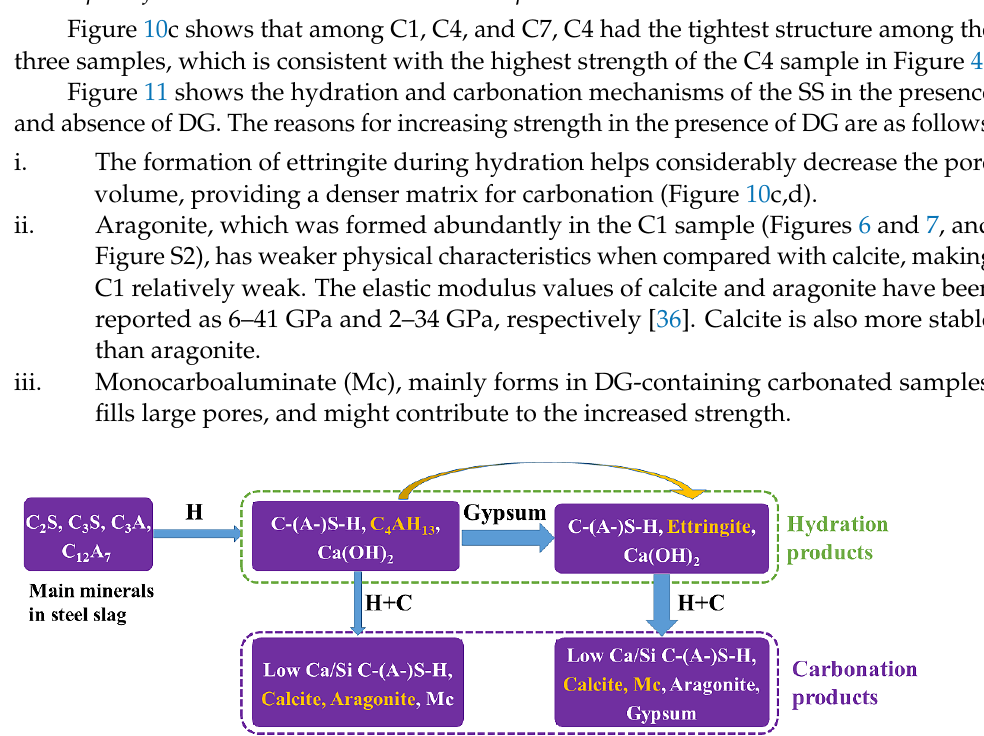
Figure 11. Hydration and carbonation mechanisms of SS in the presence and absence of DG (H: Hydration; C: Carbonation).